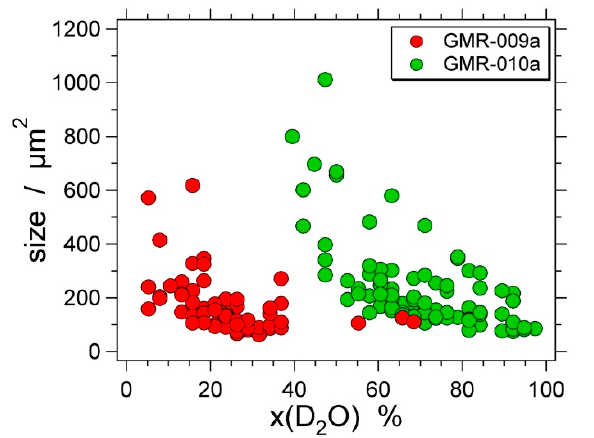
Figure 15. D 2 O composition versus fluid inclusion size (in µm 2 ), as observed from two-dimensional projections in microscope images after re-equilibration experiment GMR-009a (red symbols) and GMR-010a (green symbols).